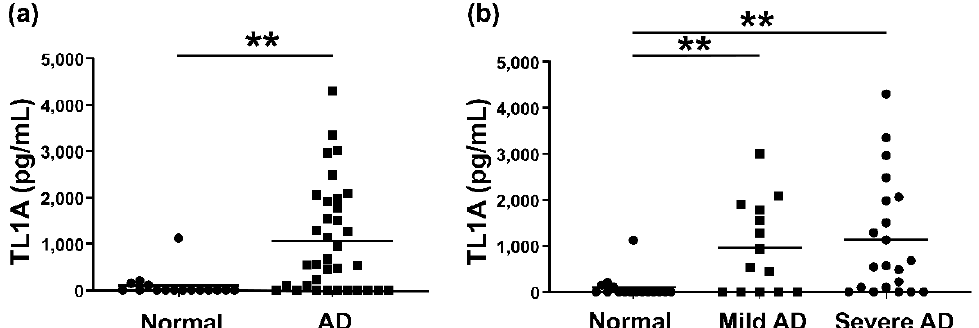
Figure 1. Serum TL1A protein levels in patients with AD and normal controls. The measured values from individual patients were plotted by dots. Each bar means the average. ** p < 0.01. ( a ) Serum TL1A protein levels in AD (n = 36) or normal controls ( n = 10). ( b ) Serum TL1A levels in mild ( n = 14) or severe ( n = 22) AD patients and normal controls ( n =